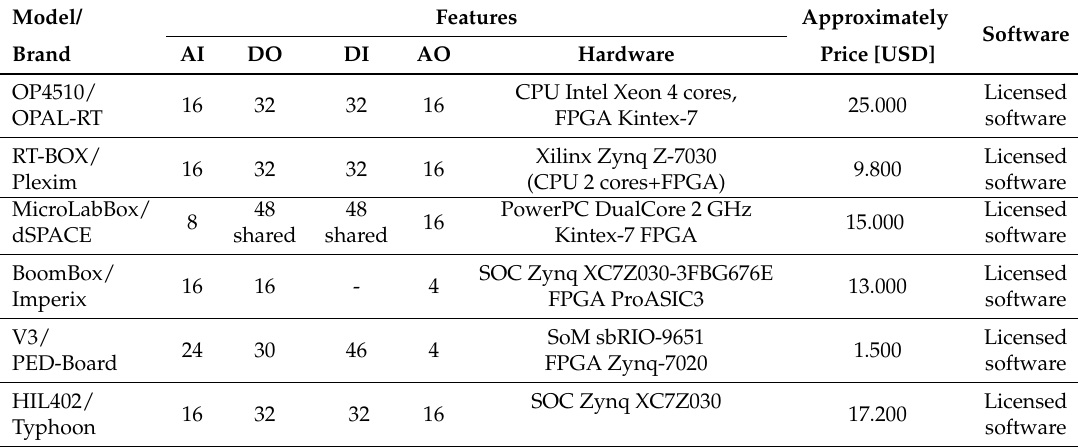
Table 1. Benchmarking of-the-shell commercial